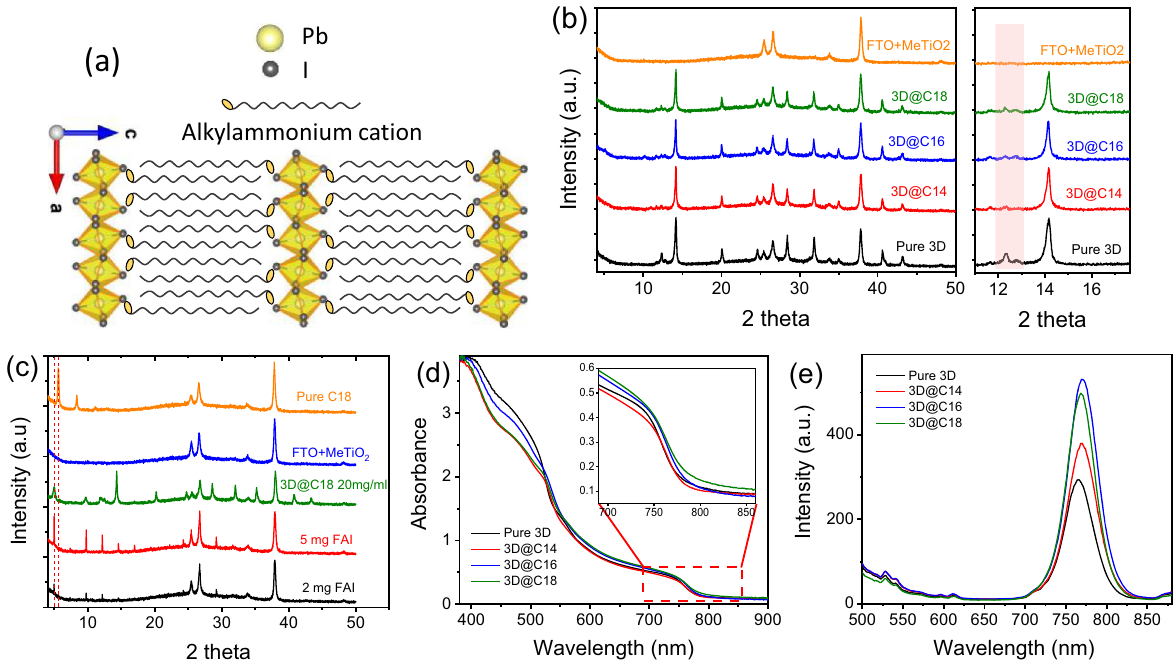
Fig. 1 Crystal structure and characterizations. a Schematic of the crystal structure of 2D perovskites at room temperature, b X-ray diffraction (XRD) patterns of 3D-only and 2D perovskite-coated thin fi lms, the panel on the right shows the enlarged view of the XRD patterns at lower angles, c XRD patterns of thin fi lms of FA-substituted C18 2D perovskites spin-coated on MeTiO 2 layer along with the XRD patterns of pure 2D perovskite and 3D@C18 (20 mg/mL) perovskite thin fi lms for comparison. d Ultraviolet – visible (UV – Vis) absorption spectra, the inset shows a small red shift in the absorption- band edge of 3D perovskite after 2D perovskite coating and e photoluminescence (PL)-emission spectra of pure 3D perovskite and 3D@2D perovskite thin fi lms.